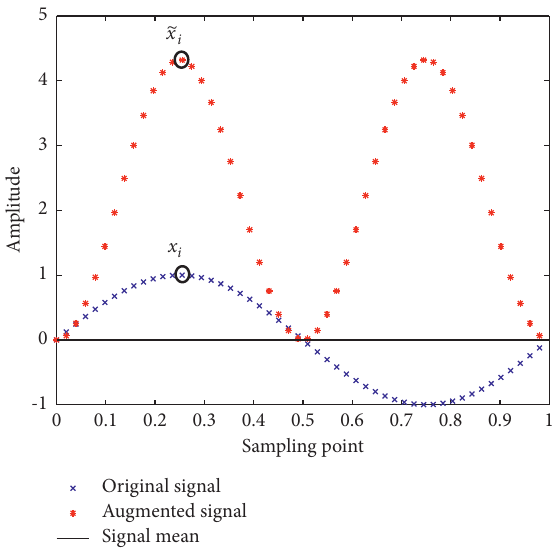
Figure 3: Flow diagram of the proposed fault diagnosis methodology.